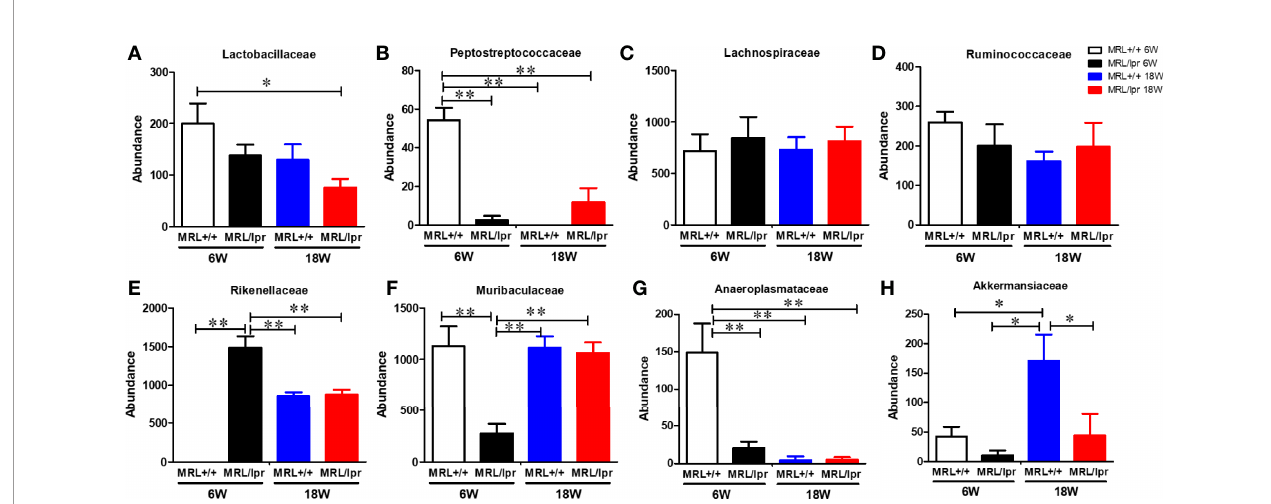
FIGURE 5 | Differential abundance of bacterial families in MRL+/+ and MRL/lpr mice at 6 and 18 weeks of age. (A) Abundance of Lactobacillaceae under Firmicutes. (B) Abundance of Peptostreptococcaceae under Firmicutes. (C) Abundance of Lachnospiraceae under Firmicutes. (D) Abundance of Ruminococcaceae under Firmicutes. (E) Abundance of Rikenellaceae under Bacteroidetes (F) Abundance of Muribaculaceae under Bacteroidetes (G) Abundance of Anaeroplasmataceae under Tenericutes. (H) Abundance of Akkermansiaceae under Verrucomicrobia. Results are mean ± SEM. n = 4 * p < 0.05; ** p < 0.01.